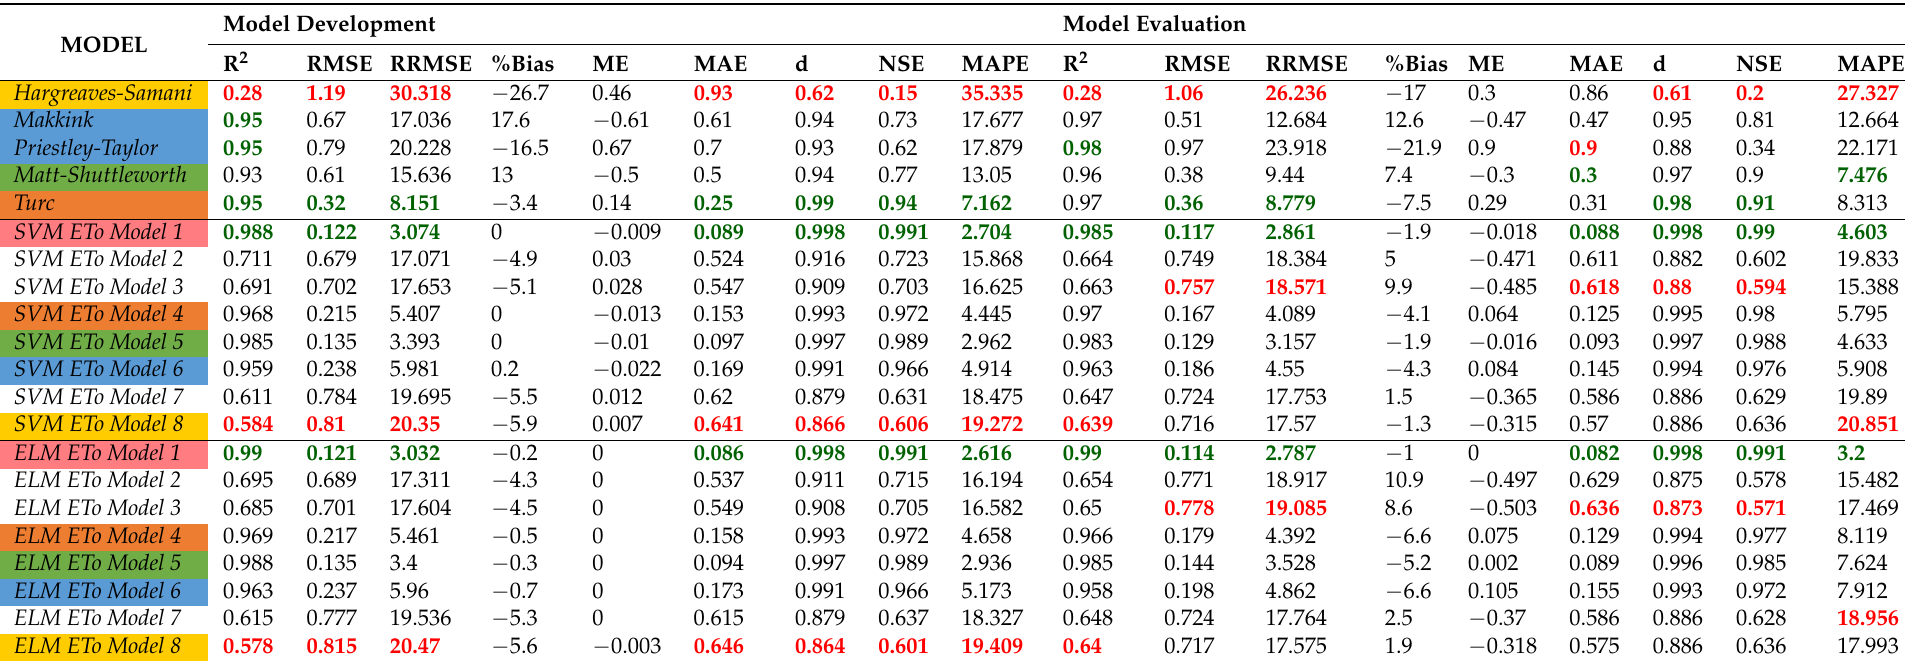
Table 5. Statistical values of empirical and machine learning models in estimating daily ETo at UPLB Station